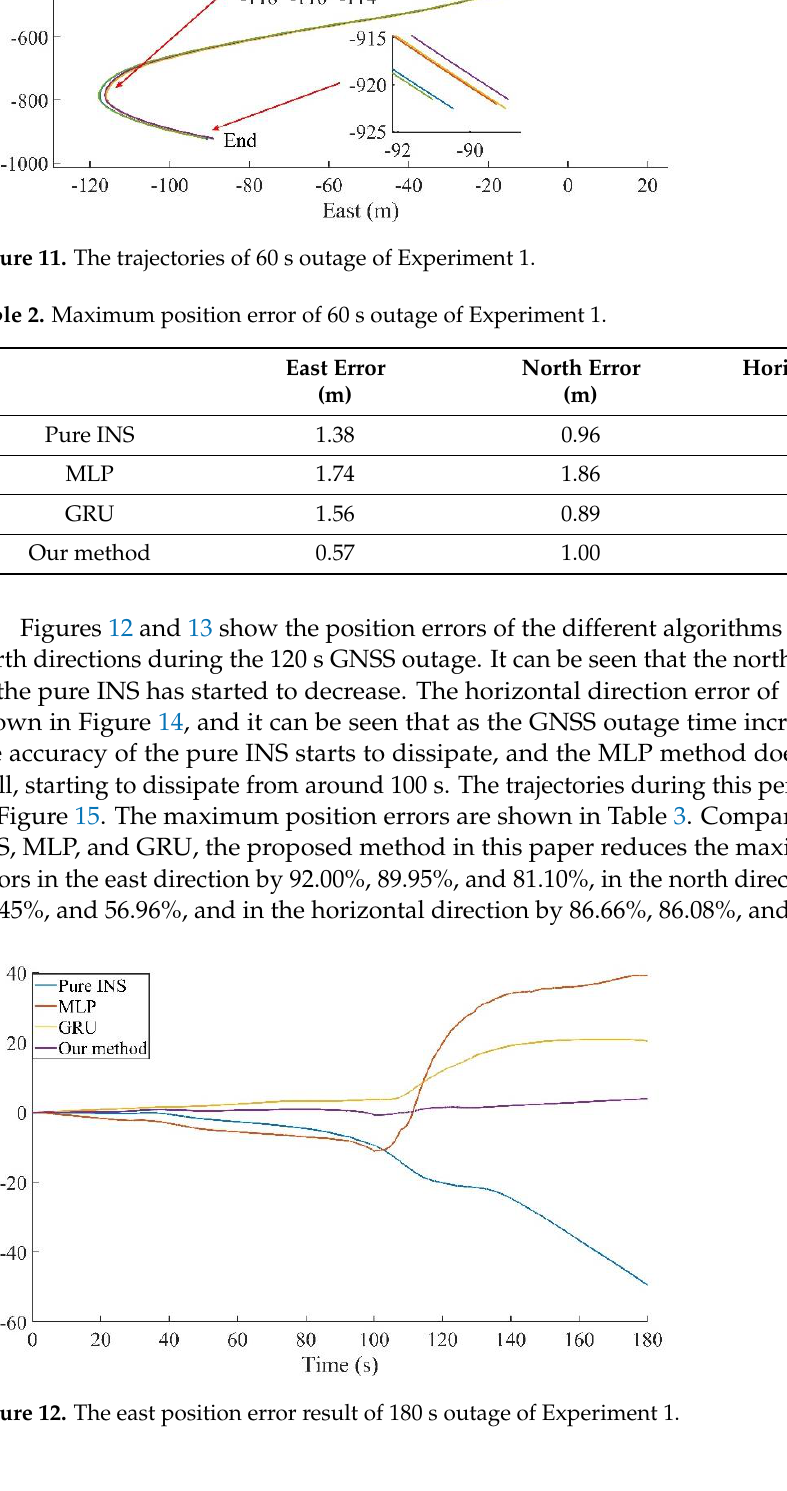
Figure 13. The north position error result of 180 s outage of Experiment 1. Figure 14. The horizontal position error result of 180 s outage of Experiment 1.